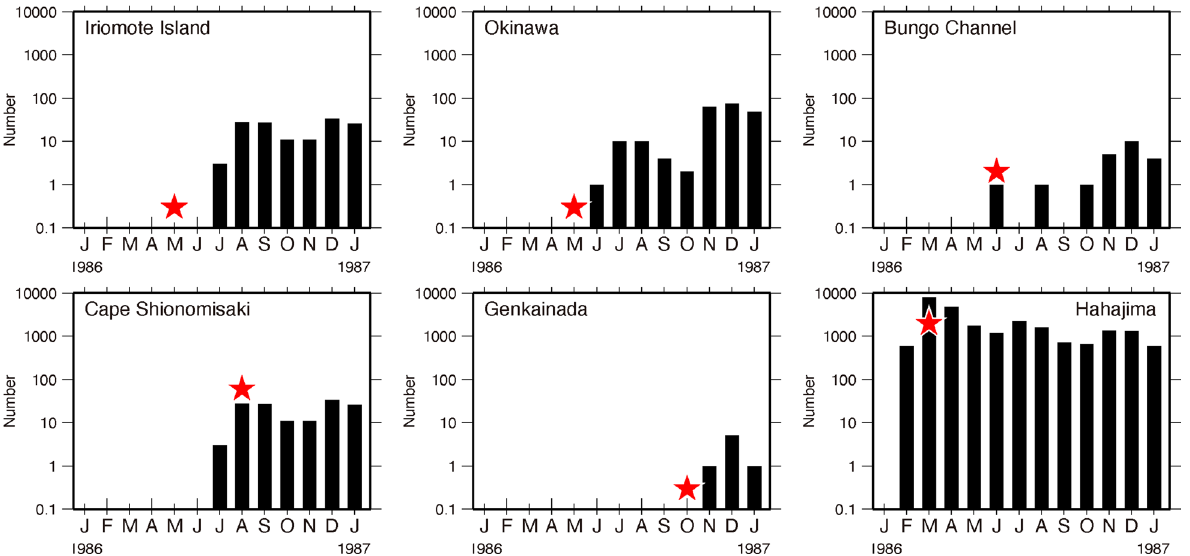
Fig. 2 Number of virtual pumice clasts that arrived at each target area from the Fukutoku-Oka-no-Ba 1986 eruption. The red stars represent the dates on which the first pumice clasts were reported at each